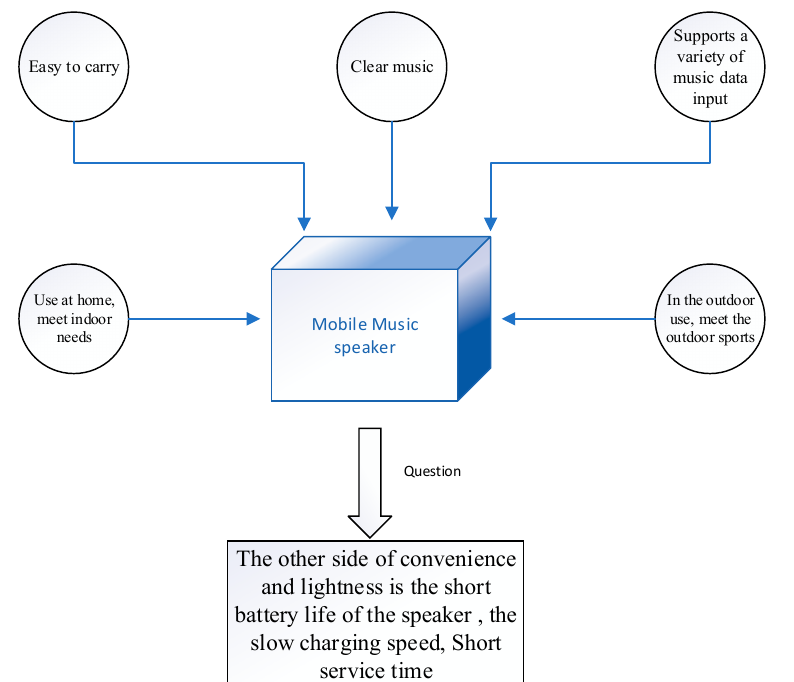
Figure 1. The advantages and problems of mobile music speakers.